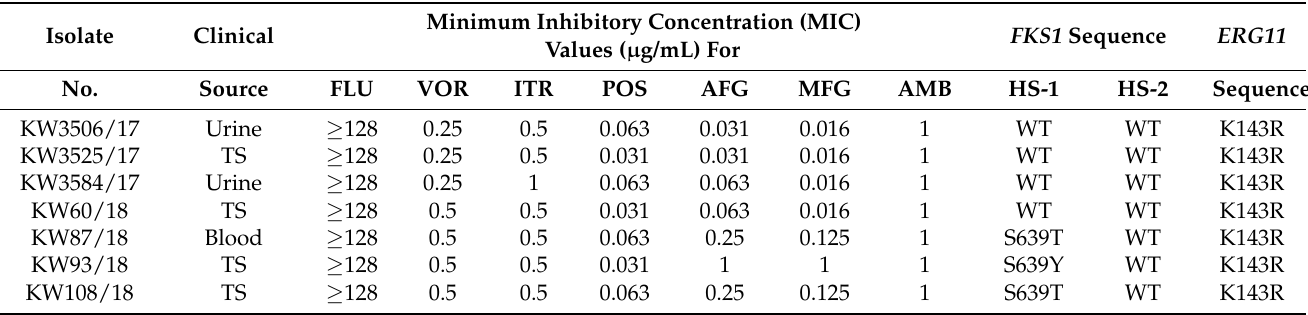
Table 1. In vitro susceptibility data for C. auris isolates against eight antifungal drugs and mutation patterns in ERG11 and FKS1